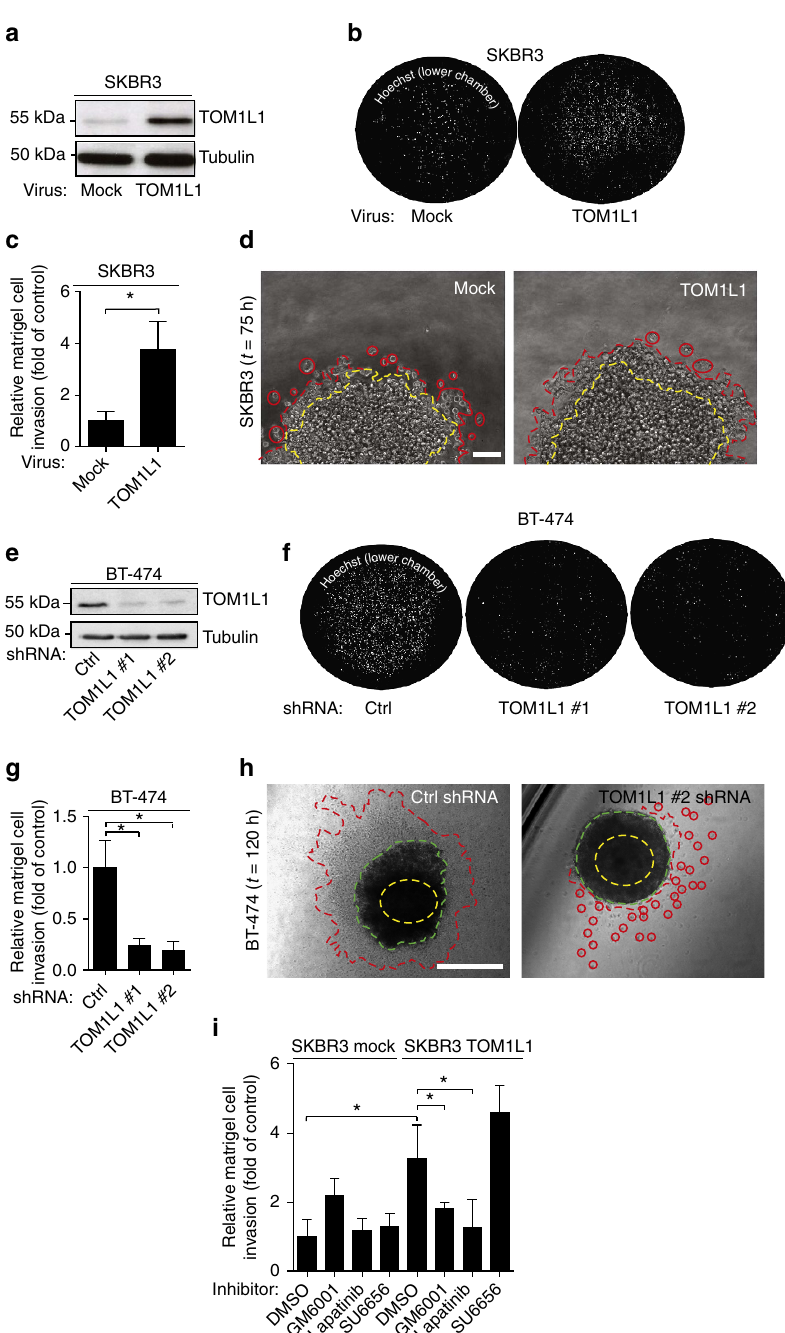
Figure 2 | TOM1L1 regulates ERBB2-driven cell invasion. ( a ) TOM1L1 expression was assessed by western blotting in SKBR3 cells infected with empty retroviruses (mock) or coding TOM1L1. ( b ) SKBR3 cells infected as in a were seeded in the upper compartment of a Boyden chamber containing 1mgml (cid:2) 1 matrigel. After 48h, cells present in the lower chamber were visualized by Hoechst staining. ( c ) Quantification of b . The histogram shows the invasion ratio normalized to control conditions ( n ¼ 3). ( d ) SKBR3 cells infected as indicated were embedded as spheroids in a collagen and matrigel matrix for 75h and then imaged by phase contrast microscopy. Yellow dotted line shows the sphere size at t ¼ 0 and the red dotted line shows invasive cells or invasive fronts at the end of the experiment. Invasive fronts were twice larger in TOM1L1-expressing cells than in controls cells ( n ¼ 4). Scale bar, 100 m m. ( e ) TOM1L1 expression was assessed by western blotting in BT-474 cells infected with viruses containing control shRNA (Ctrl) or two different TOM1L1 shRNAs (TOM1L1 #1 and #2). ( f ) Invasion of the BT-474 infected cells was assessed in Boyden chambers with matrigel as in b . Cells in the lower chamber were stained with Hoechst and counted as in c ( n ¼ 3) ( g , h ) Infected BT-474 cells were embedded as spheroids in a collagen and matrigel matrix for 5 days and imaged by phase contrast microscopy. Yellow dotted line shows sphere size at t ¼ 0, green dotted line shows sphere size at t ¼ 120h and red dotted line shows invasive cells or invasive fronts. The surface explored by the cells was decreased by 1.5-fold in TOM1L1 silenced cells compared with controls ( n ¼ 3). Scale bars, 400 m m. ( i ) SKBR3 cells infected as indicated were seeded in Boyden chambers as in b , c and incubated with DMSO, 12.5 m M GM6001 (MMP inhibitor), 1 m M lapatinb (an EGFR/ERBB2 inhibitor) and 2 m M SU6656 (SRC inhibitor) for 48h. The histogram shows the invasion ratio normalized to control conditions ( n ¼ 10). All histograms in Fig. 2 show mean ± s.e.m. * P r 0.05 (Student’s t